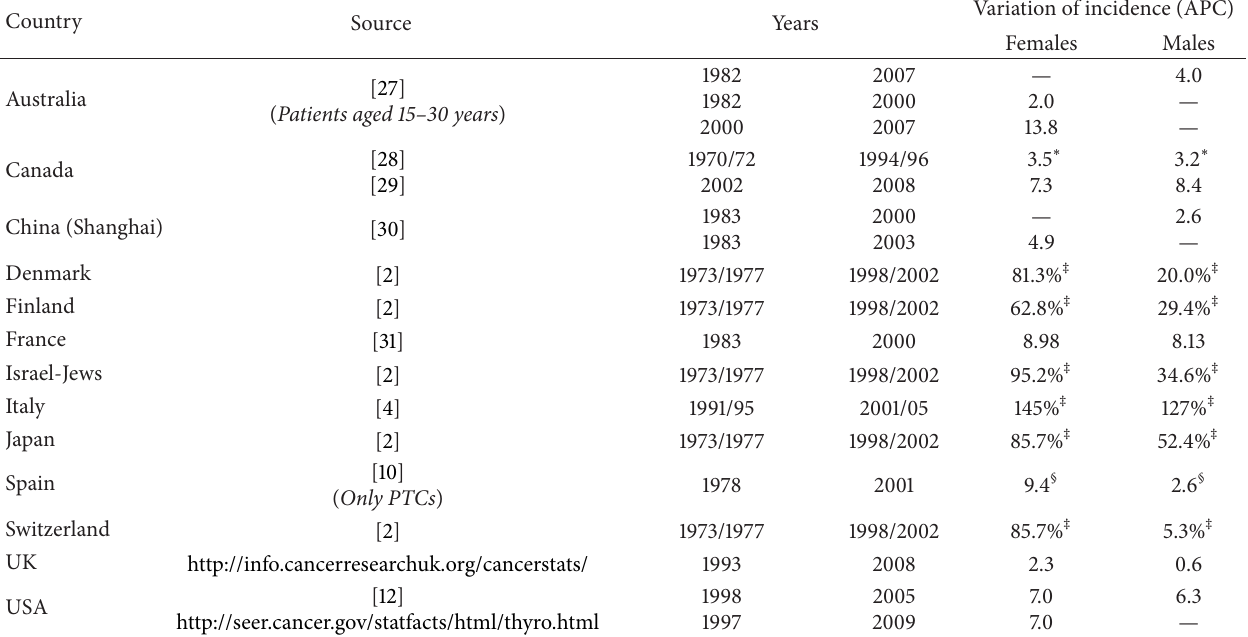
Table 1: Increase of thyroid cancer incidence rate in different